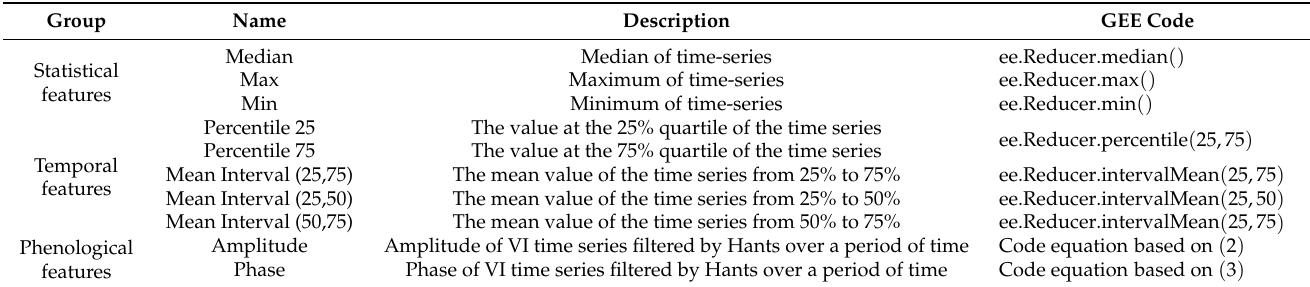
Table 3. Selection of vegetation index (VI)